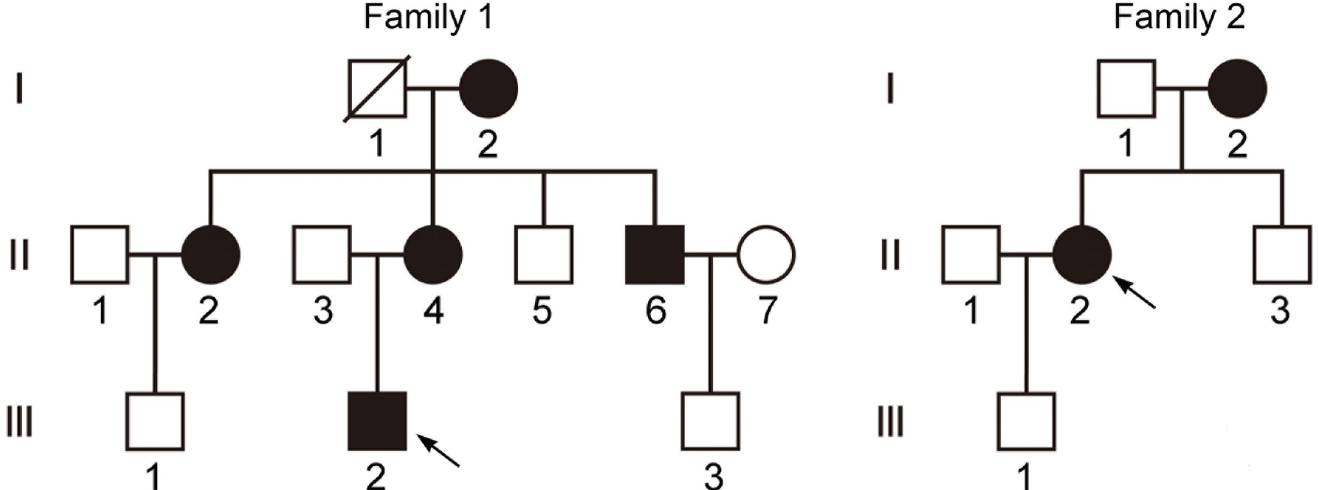
Fig 1. Pedigrees of family 1 and family 2 with mutations in the UBAP1 gene. Squares and circles indicate males and females, respectively. Black symbols represent members with an HSP phenotype and empty symbols represent unaffected individuals. Arrows indicate the probands.